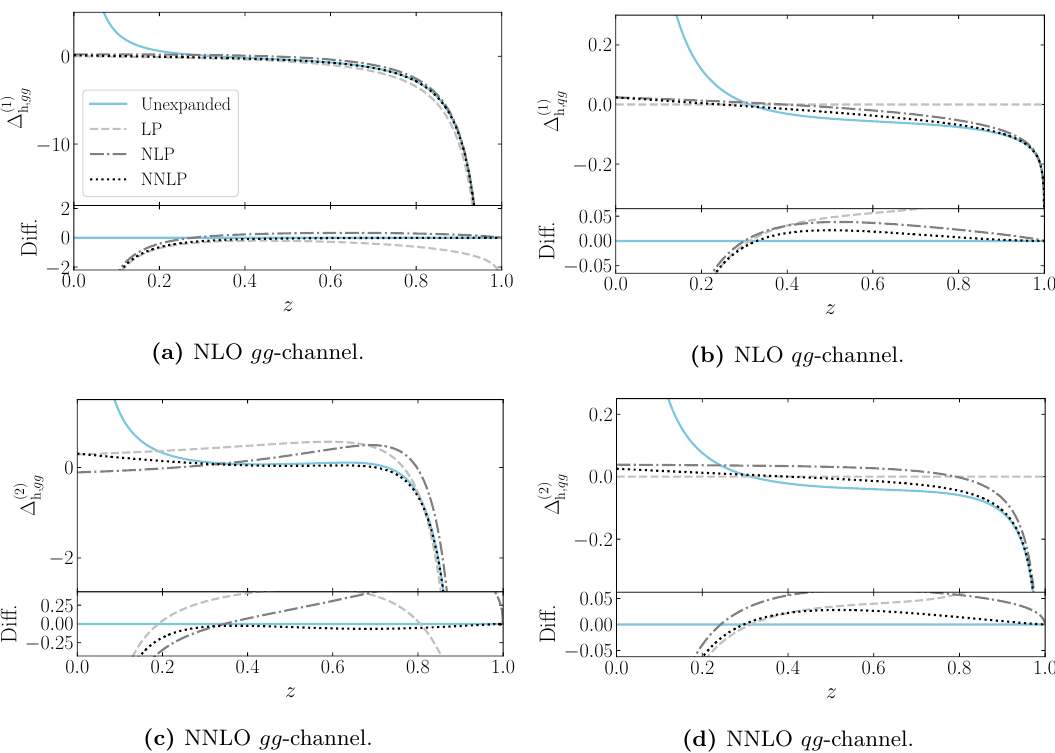
Figure 1. Threshold expansions of the NLO (a,b) and NNLO (c,d) coefficients for single Higgs production. The unexpanded expressions are indicated by the coloured line, while the grey dashed, grey dash-dotted and black dotted lines show the LP, NLP and NNLP truncated expressions respec- tively. The bottom panes show the difference between the truncated and unexpanded expressions. The y -axis range of these difference plots is fixed at 20% of the range of ∆ (1) shown in the upper h panes, for a uniformized comparison. We use eq. (45), (46) and eq. (48)-(50) in ref. [60]) for the unexpanded form of the partonic coefficients. Note that we have included the (trivial) LP approx- imation of the qg -channels, which vanishes, as these channels start contributing at